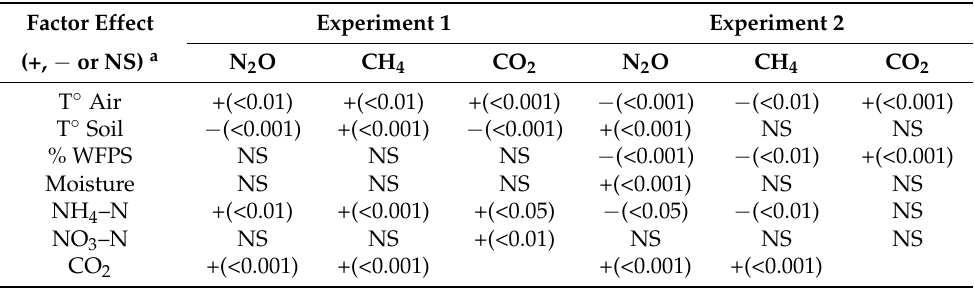
Table 2. Multiple linear regression to determine the association between edaphoclimatic variables and greenhouse gas